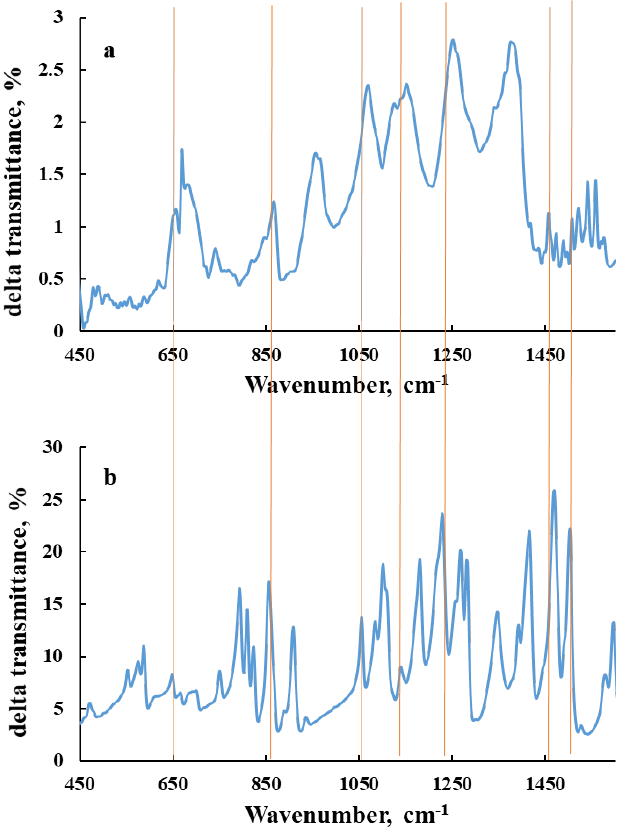
Figure 4. FT-IR spectra of the 5 wt.%-triclosan-loaded polymer composite ( a ) and triclosan ( b ).